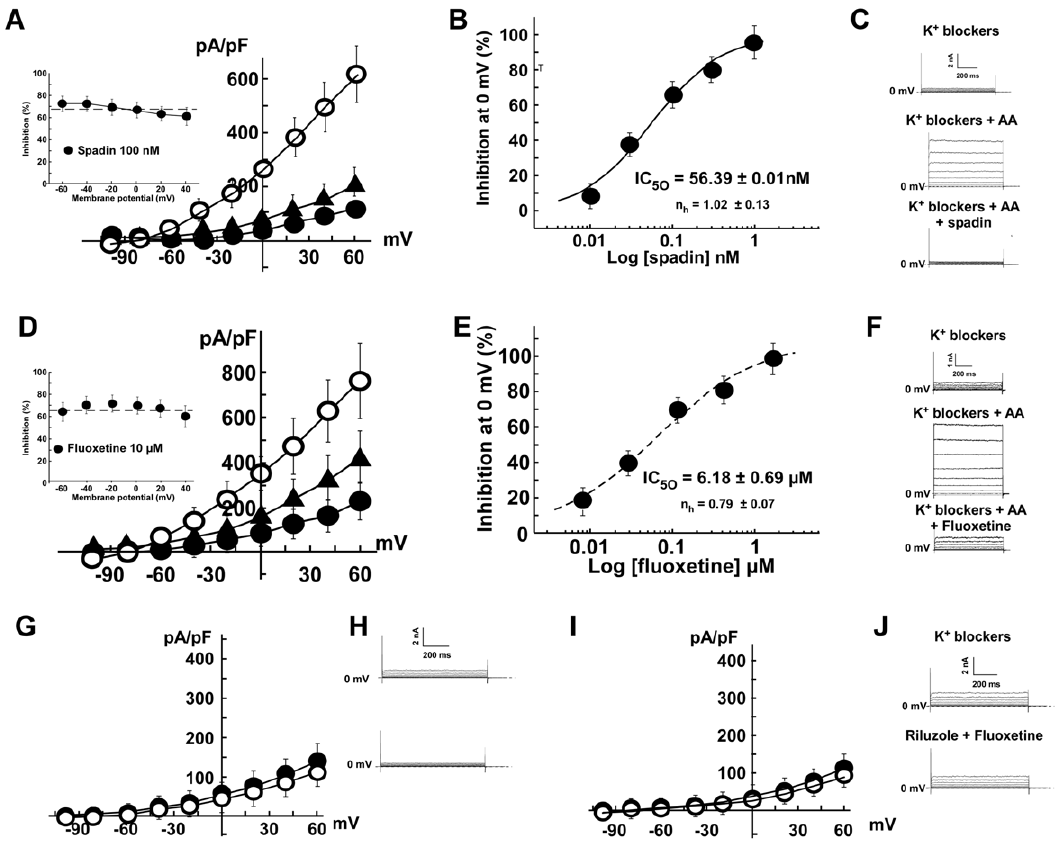
Figure 4. Pharmacological inhibition of h-TREK-1 current in whole cell patch clamp configuration by spadin (n=12 for each dose) and fluoxetine (n=12 for each dose). Currents were recorded in the presence of a cocktail of potassium channel inhibitors (K + blockers). The inhibition was obtained after the pre-activation of the current by 10 m M AA. A) Current/potential curves obtained in presence of K + blockers (closed circles), K + blockers + AA (open circles) and K + blockers + AA + spadin 1 m M (closed triangles). The absence of voltage dependence of spadin inhibition (100 nM) was shown in the inset. B) Spadin dose dependent inhibition at 0 mV potential. C) Typical traces of hTREK-1 current pre-activated by 10 m M AA and inhibited by 1 m M spadin. D) Current/potential curves obtained in the presence of K + blockers (closed circles), K + blockers + 10 m M AA (open circles) and K + blockers + 10 m M AA + 30 m M fluoxetine (closed triangles). The absence of voltage dependence of fluoxetine inhibition (10 m M) was shown in the inset. E) Fluoxetine dose-dependent inhibition at 0 mV potential. F) Typical traces of h-TREK-1 current pre-activated by 10 m M AA and inhibited by 30 m M fluoxetine. G, H) Current/potential curves and representative traces of spadin inhibition (1 m M) on 100 m M riluzole activated hTREK-1 current (n=10). I, J) Current/potential curves and representative traces of fluoxetine inhibition (30 m M) on 100 m M riluzole activated hTREK-1 current (n=10).